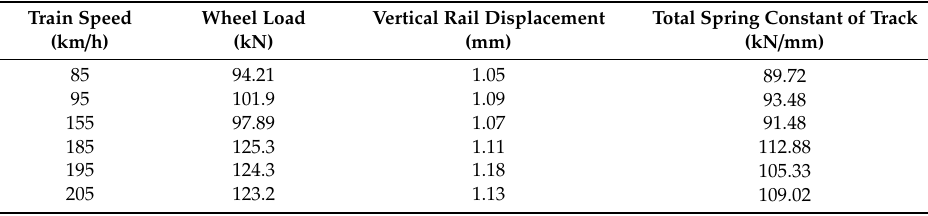
Table 12. Total spring constant of ballasted track (Field